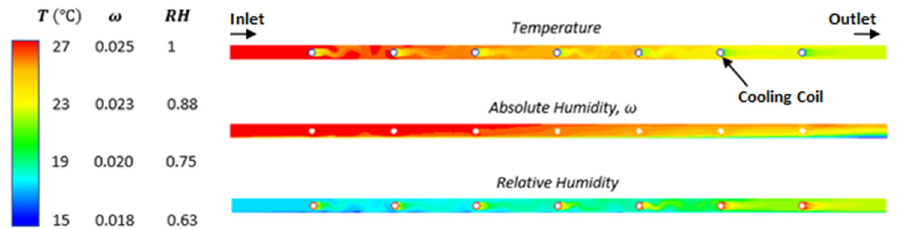
Figure 4. CFD contour results for temperature (top), specific humidity (middle) and RH (bottom). L × W × H = 0.6 m × 0.006 m × 1 m v in = 5m/s, T in = 27 ℃ , RH in = 70%, T coil = 10 ℃ , B = 3500 GPU.